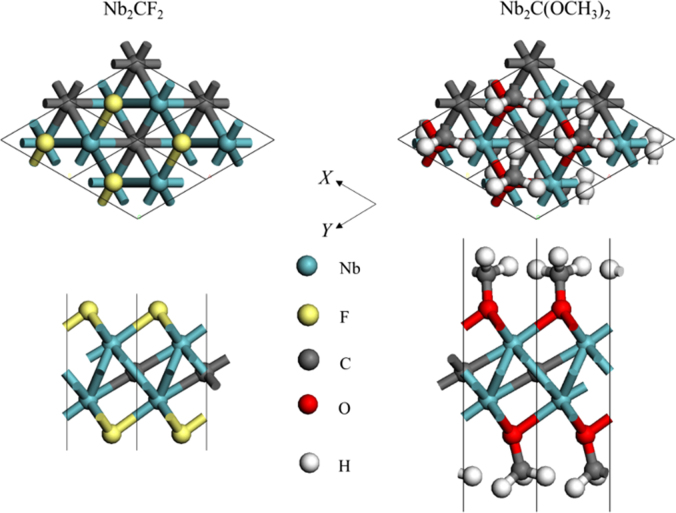
Top views and side views from the X direction of the optimal structures of Nb2CF2 and Nb2C(OCH3)2.